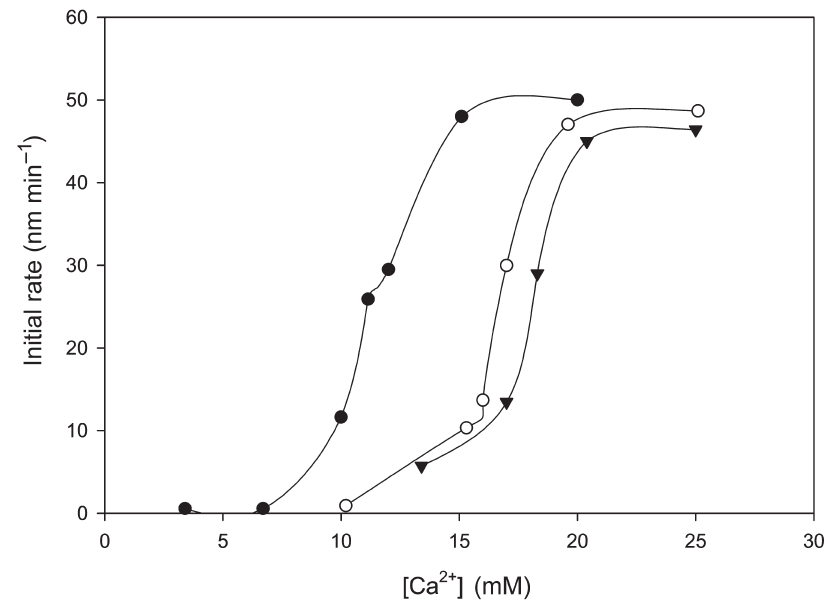
Figure 6. Plots of the initial rate of Ca 2+ -induced PLFE vesicle aggrega- tion versus Ca 2+ concentration ([Ca 2+ ]) at 25 °C ( (cid:2) ), 40 °C ( (cid:3) ) and 54 °C ( (cid:4) ) in 50 mM KCl (pH